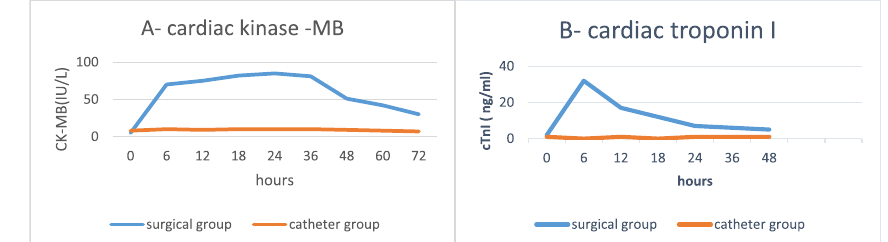
Fig. 3 A cardiac kinase‑MB levels during 3 days of follow‑up. B Troponin I levels during 2 days of follow‑up. CK‑MB, cardiac kinase‑MB; cTnI, cardiac troponin